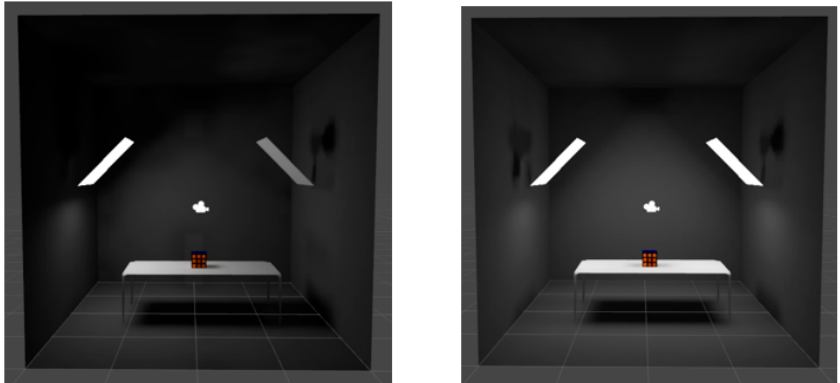
Figure 13. The light conditions and shadow in the virtual environment. The intensity of the virtual environment was set to be equal to the real space. The left figure shows a situation in which one of the studio lights is turned on, and the right figure shows a situation in which two lights are turned on.